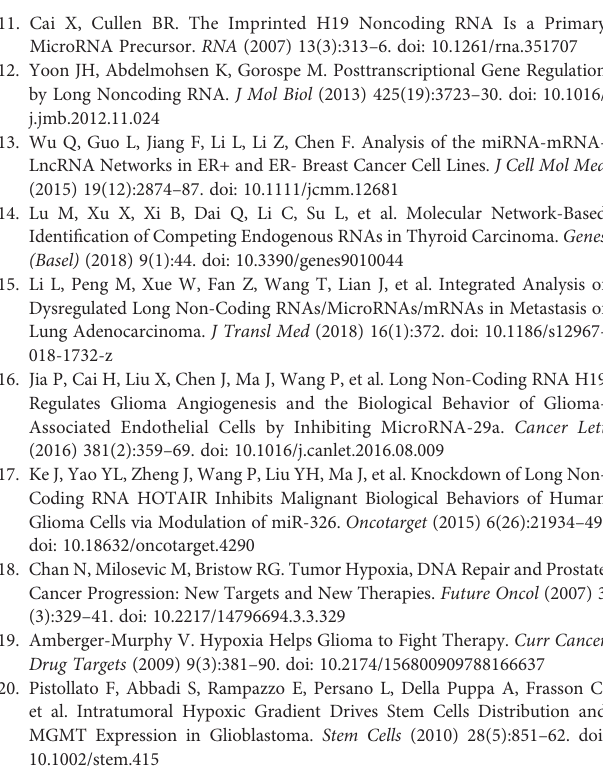
Supplementary Figure 1 | Differentially expressed genes in glioma and non- cancerous tissues based on TCGA database. Supplementary Figure 2 | Differentially expressed genes in glioma and non- cancerous tissues based on GSE42658. Supplementary Figure 3 | The effects of OR7E156P on the primary human glioma cells ’ proliferation and invasion. (A) Phenotypesof theprimary humanglioma cells captured by microphotography are displayed. (B) Immunocytochemistry for GFAP and S100B was done in primary human glioma cells (glioma-PC), U251-MG and U87-MG cells. (C) OR7E156P silencing was achieved in primary human glioma cells by infecting cells with lentivirus containing short hairpin RNA for OR7E156P (Lsh1-OR7E156P or Lsh2-OR7E156P). Lsh-NC was infected as a negative control. The silencing ef fi ciency was veri fi ed by qRT-PCR. Then, primary human glioma cells were infected with Lsh1-OR7E156P or Lsh-NC and examined for cell invasion by Transwell assay (E) ; DNA synthesis capacity by EdU assay (F) . Supplementary Figure 4 | The BioCarta tool from (https://www.gsea-msigdb. org/gsea/) was used to verify the association between OR7E156P and HIF signaling